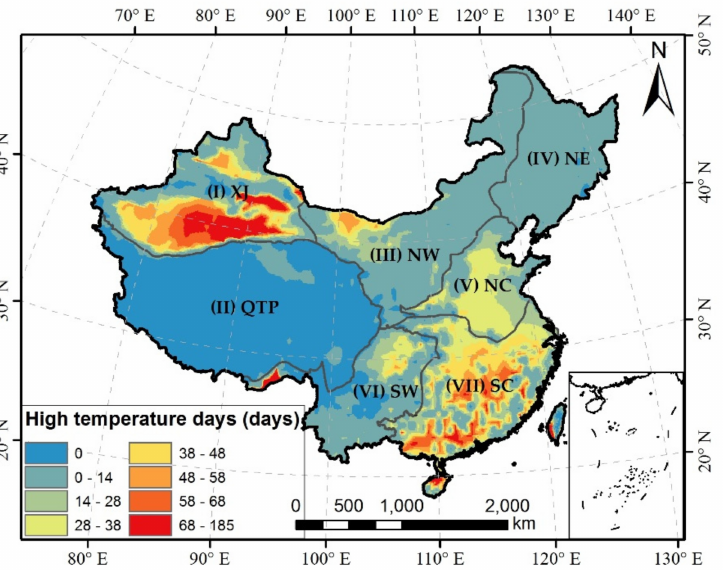
Figure 2. Spatial distribution of annual mean high-temperature days over China during 1979–2018.